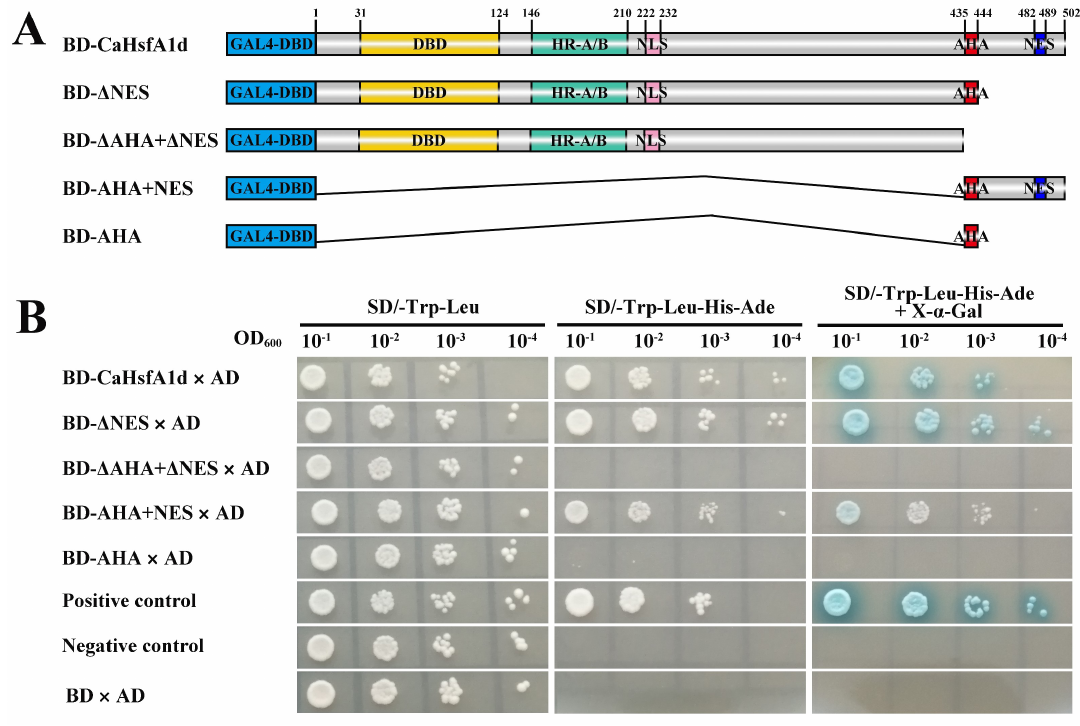
Figure2. Transactivationassayofthe CaHsfA1d proteininyeastcells. ( A )Schematicrepresentationofthe full-length CaHsfA1d and deletion protein constructs in the pGBKT7 vector. ( B ) Growth of transformed yeast cells 3 days after spotting on selective mediums. Positive control, yeast cells transformed with pGBKT7-53 and pGADT7-T; Negative control, yeast cells transformed with pGBKT7-Lam and pGADT7-T. Experiments were performed three times with similar